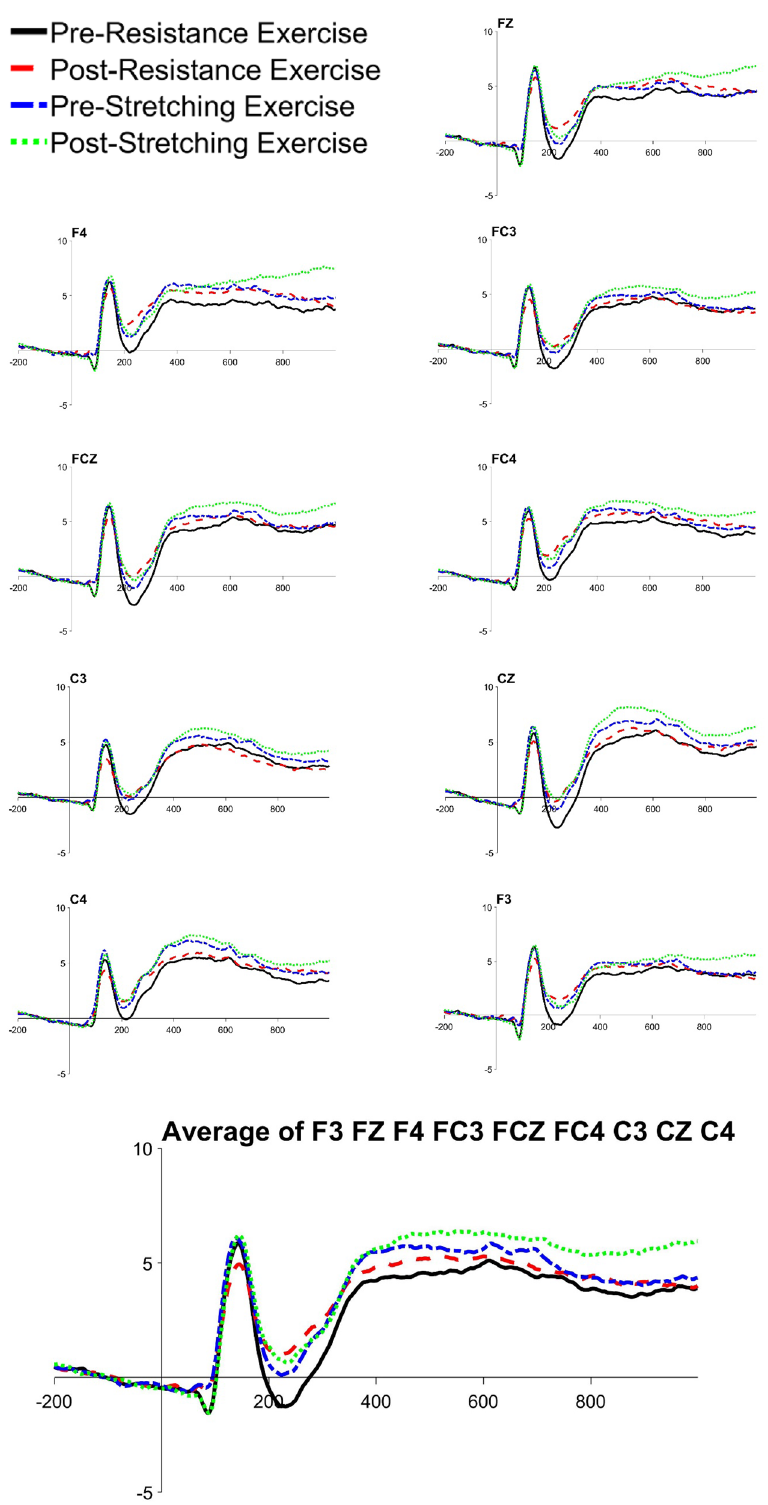
Figure 3. The grand averages of frontocentral electrodes in congruent condition. Drawn by ERPlab 7.0 64